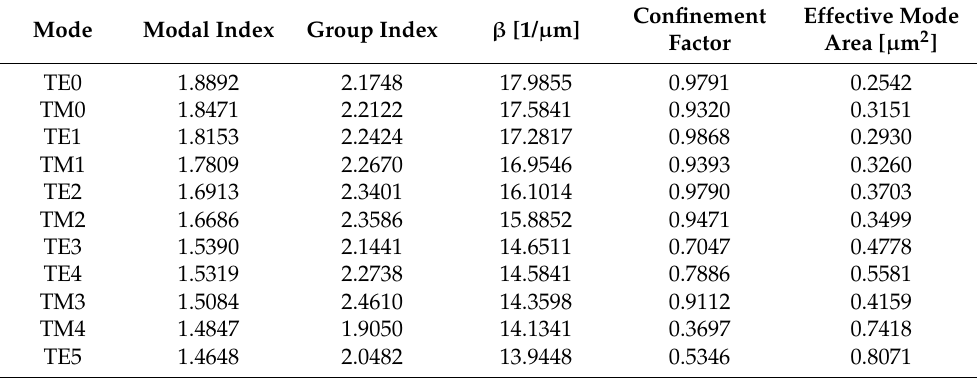
Table 1. Mode parameters simulations results for straight waveguide width 1.0 µ m, a chosen waveguide width for routing of fabricated multimode interferometers (MMIs) and arrayed waveguide gratings (AWGs). Assumed wavelength of operation was 660 nm.